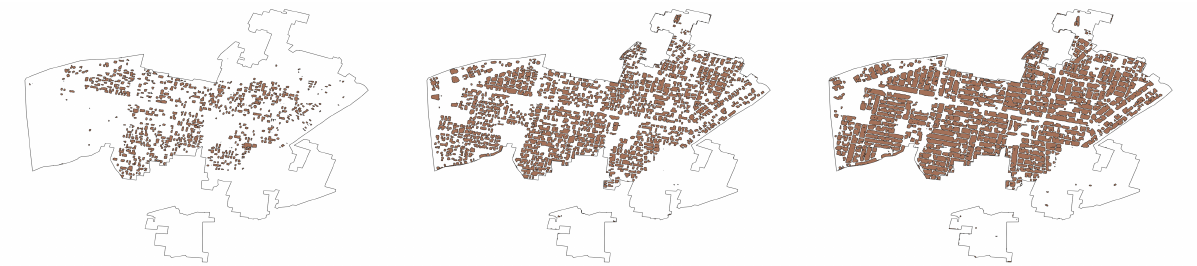
Figure 8. Growth in Phase-5 DHA: The analysis results on one of the regions (Phase 5) of DHA. The left most image is for 2010, the center image is for 2014, and the last image is for 2020.